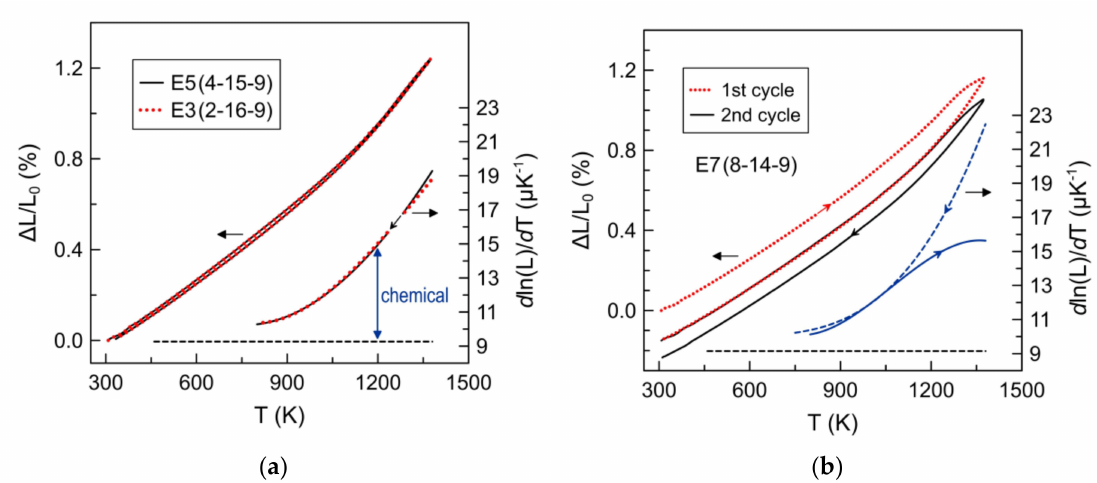
Figure 7. ( a ) Dilatometry of representative samples fired at 1500 ◦ C (E5 (4-15-9)) and 1600 ◦ C (E3 (2-16-9)) and corresponding changes in the thermochemical expansion coe ffi cient (right axis).; ( b ) Consecutive dilatometry scans of sample E7 (8-14-9), and corresponding thermochemical expansion coe ffi cient (right axis) extracted from the second cycle. Arrows indicate heating or cooling